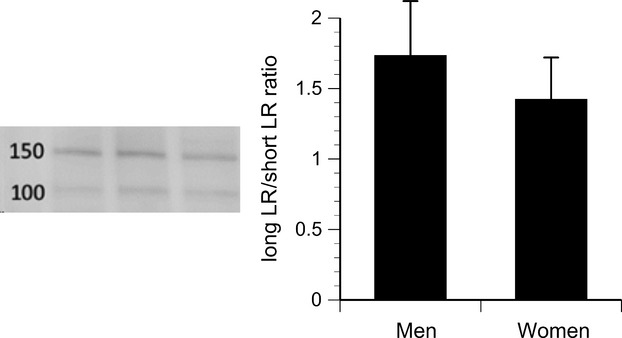
Left: Western blot results for three subjects showing relative expression of long leptin receptor isoform (150 kDa) and short isoforms (100 kDa). Right: Densitometric measurements are presented as the ratio of long/short isoforms, for men versus women. No statistically significant sex difference was observed.